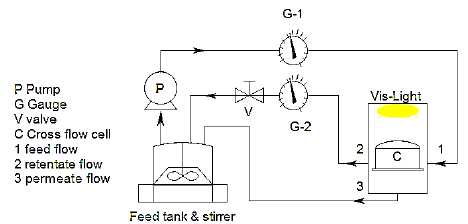
Figure 1. Schematic of photocatalytic cross flow system.